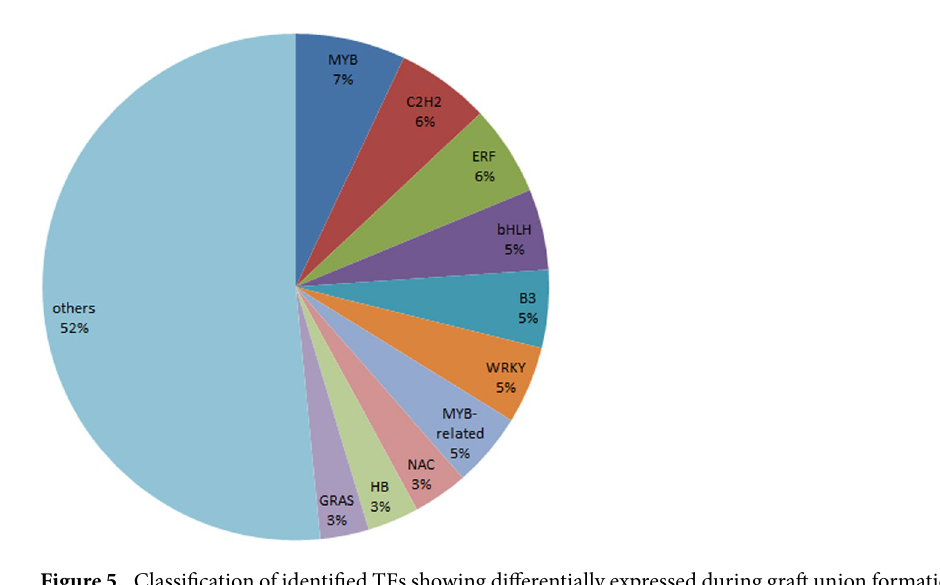
Figure 5. Classification of identified TFs showing differentially expressed during graft union